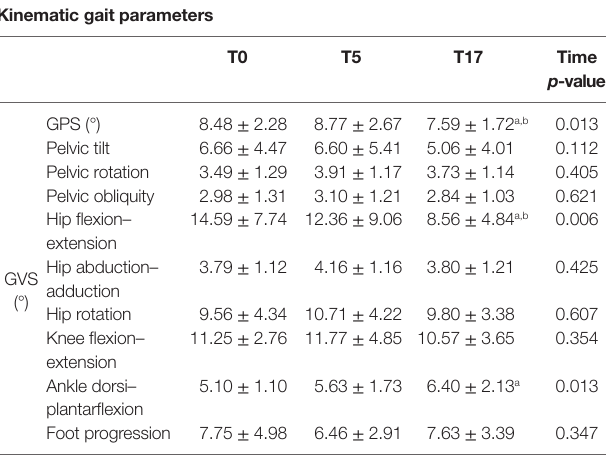
Table 4 | comparison between kinematic parameters of gait assessed before and after